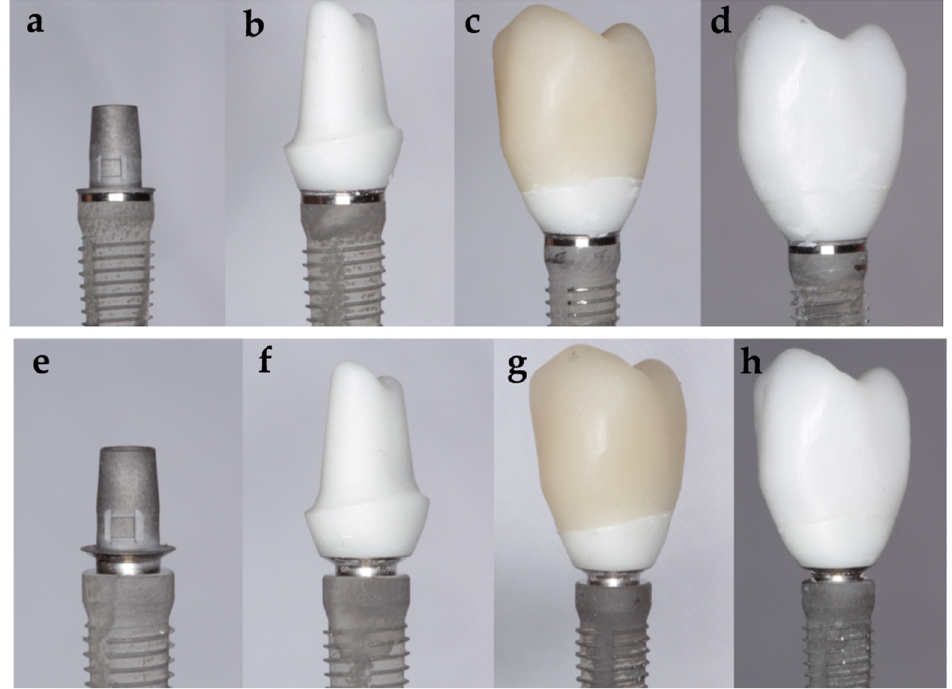
Figure 1. Test groups: ( a ) Tube − tube implant − abutment connection; ( b ) zirconia abutment; ( c ) lithium disilicate crown (Tube ZLD); ( d ) zirconia crown (Tube ZZ); ( e ) conical implant − abutment connection for platform switching supporting; ( f ) zirconia abutment; ( g ) lithium disilicate crown (Conical ZLD); ( h ) zirconia crown (Conical ZZ).